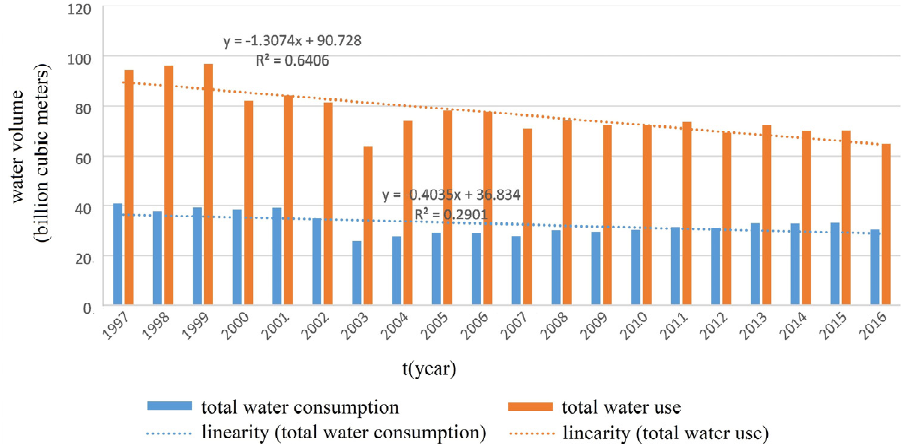
Figure 12. Changes in water consumption in the Yellow Irrigation District.